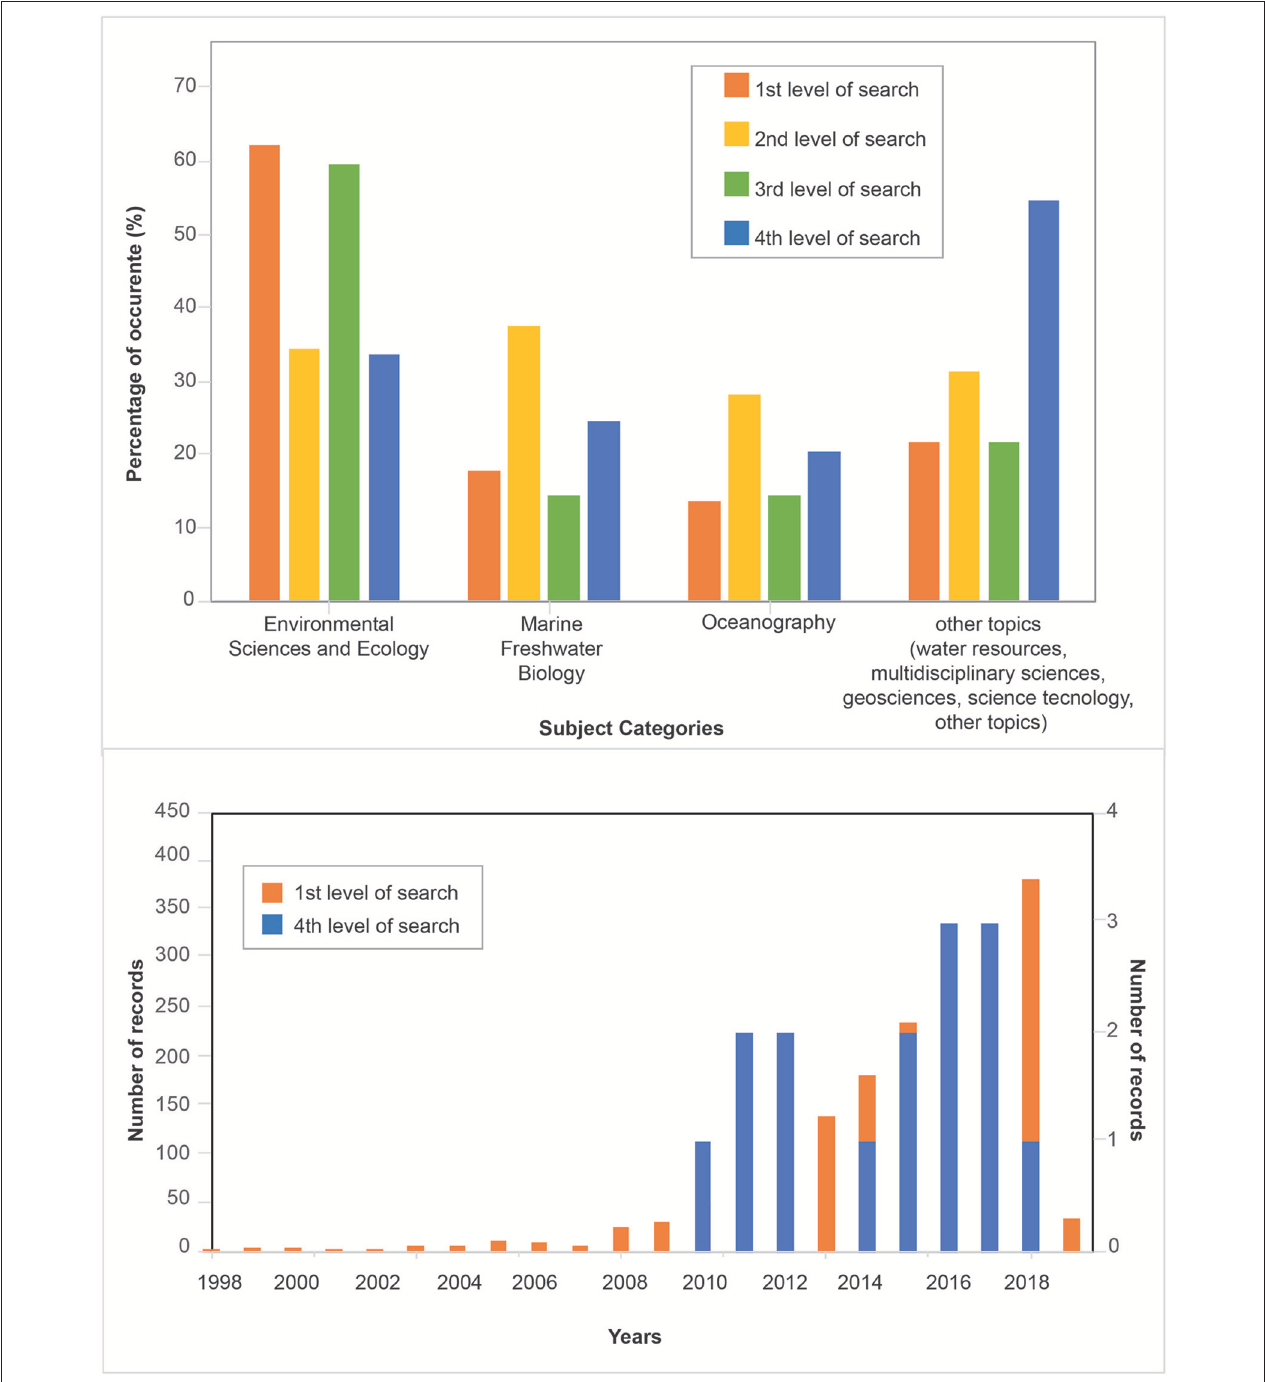
FIGURE 1 | Above, records reporting coastal ecosystem services, morphology analyses, and salt marsh strings obtained for the last 20 years, for the four levels of search, distributed within the five main WoS categories; below, comparison between the number of records obtained for the last 20 years in the first level of search and in the fourth level of